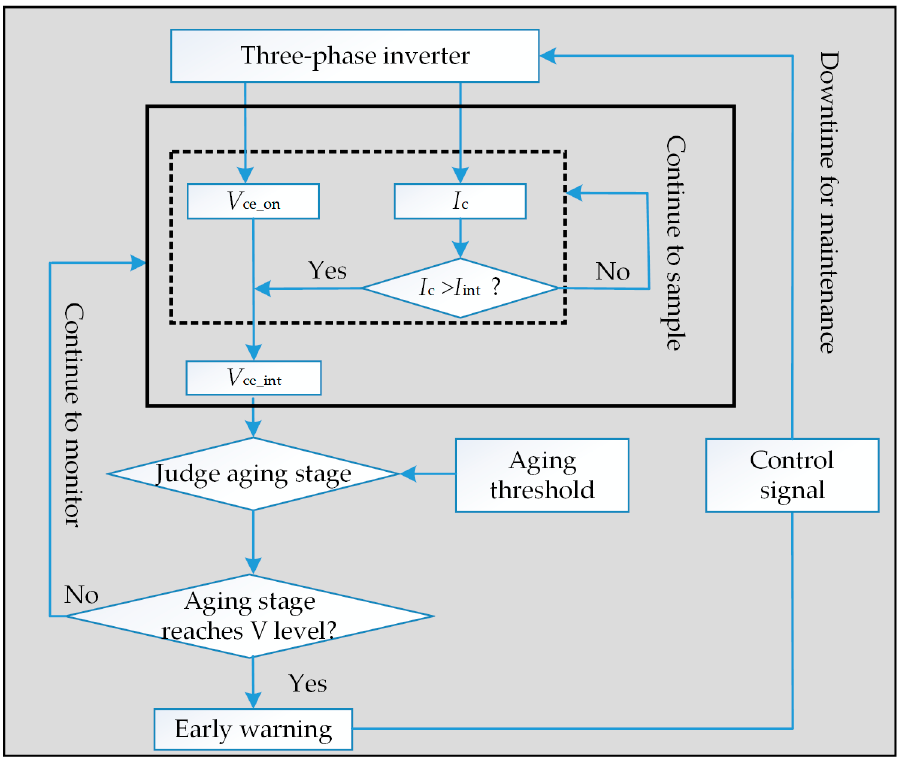
Figure 4. Voltage and current sampling circuit.